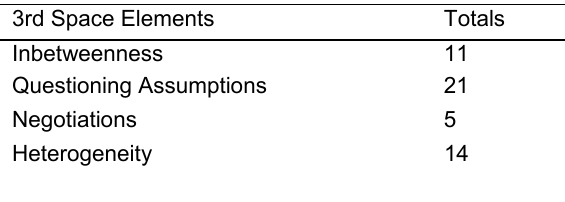
Table 2. Totals for each element of the 3 rd Space